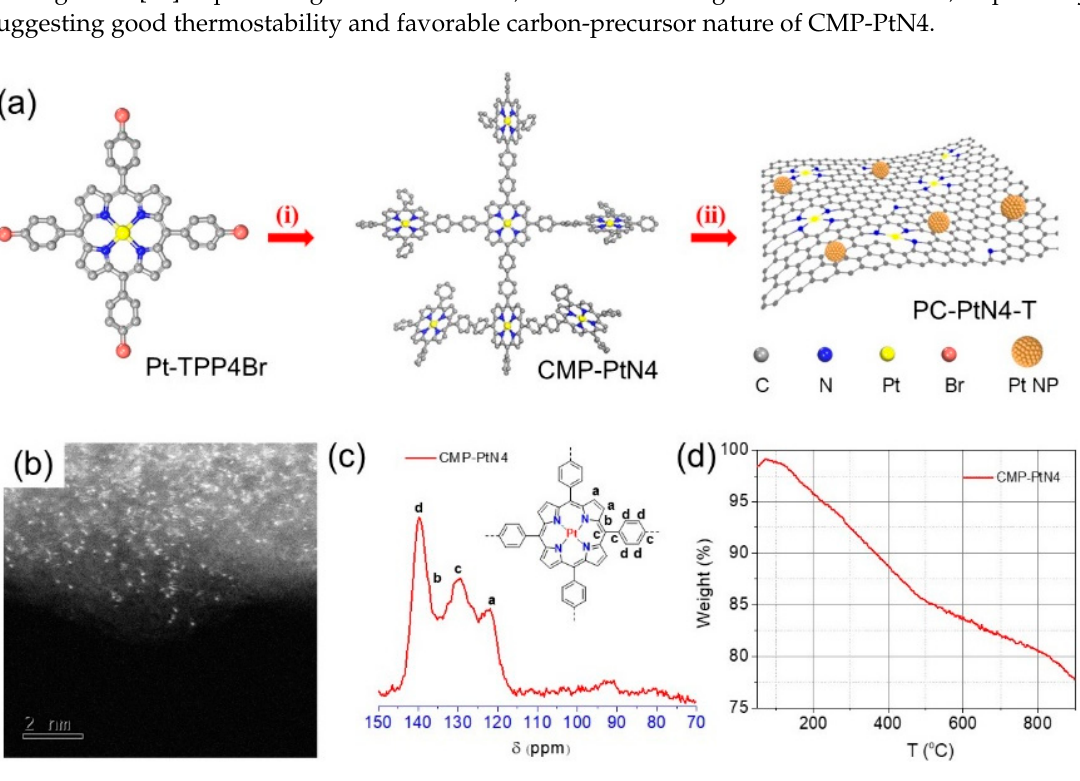
Figure 1. (a) Schematic representation of the synthesis route of PC-PtN4-T: ( ⅰ ) N 2 , Ni(cod) 2 , cod and Figure 1. ( a ) Schematic representation of the synthesis route of PC-PtN4-T: (i) N 2 , Ni(cod) 2 , cod and 2,2 ′ -bipyridyl, 80 °C, 3 days, ( ⅱ ) N 2 , T °C (T=600, 900), 2 h. HAADF-STEM image (b), 13 C ssNMR 2,2 (cid:48) -bipyridyl, 80 ◦ C, 3 days, (ii) N 2 , T ◦ C (T = 600, 900), 2 h. HAADF-STEM image ( b ), 13 C ssNMR spectrum (c), and TGA curve (d) of CMP-PtN4. spectrum ( c ), and TGA curve ( d ) of